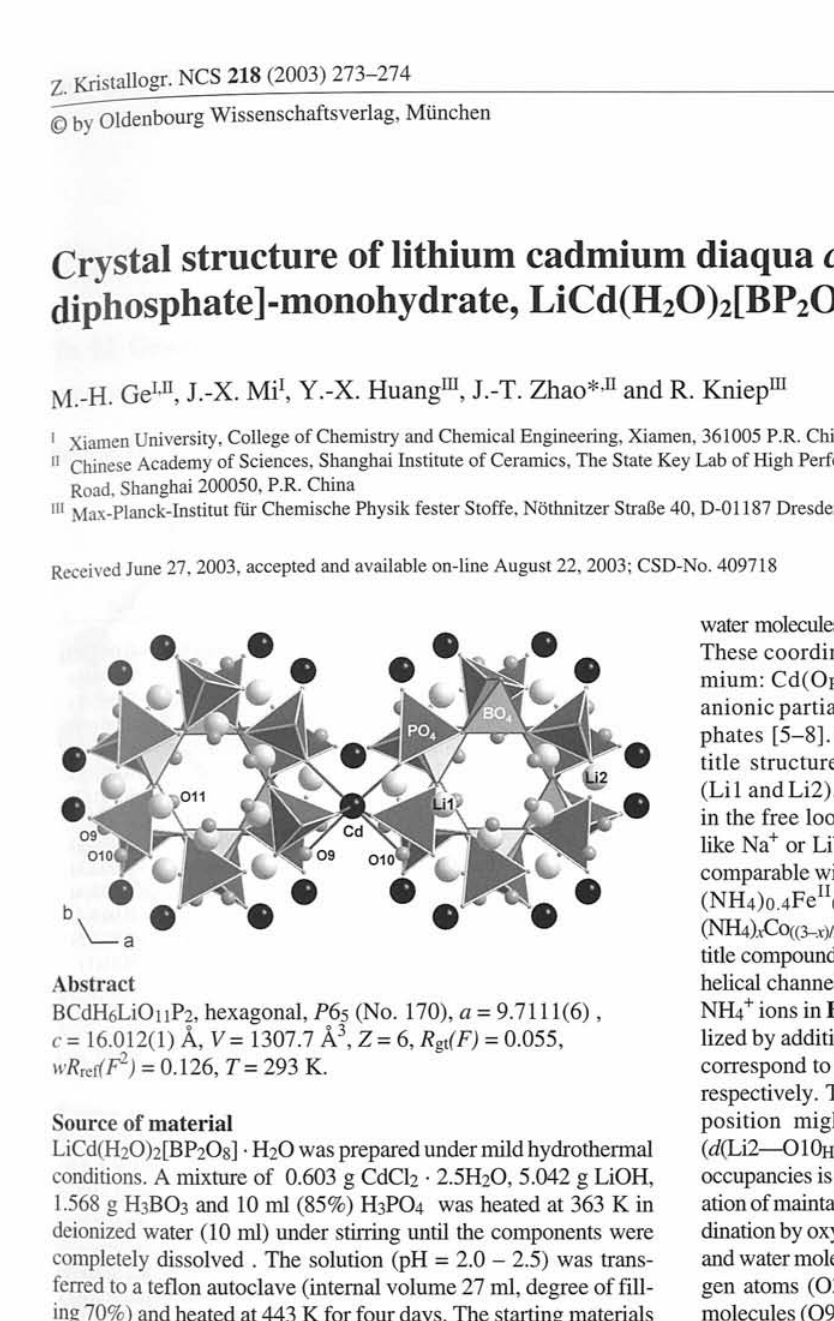
Table 1. Data collection and